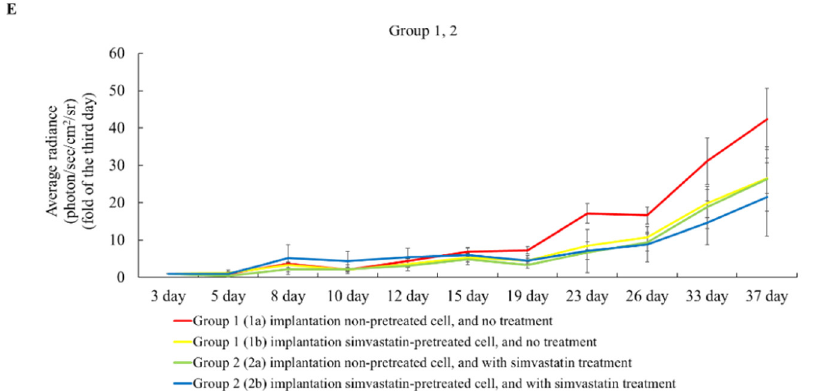
Figure 3. BxPC-3 cell subcutaneously induced pancreatic cancer mice model. ( A ) Group 1: Implant